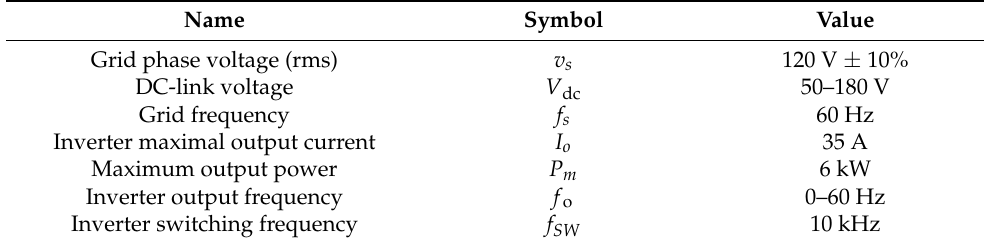
Table 1. Specifications of the FB power cell.